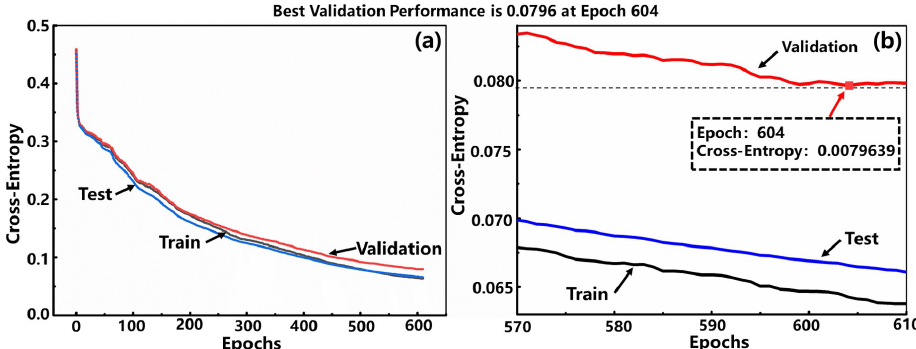
Figure 3. The training procedure of the proposed ANN. Training of the ANN is performed by using measured resistance changes data of the sensor.